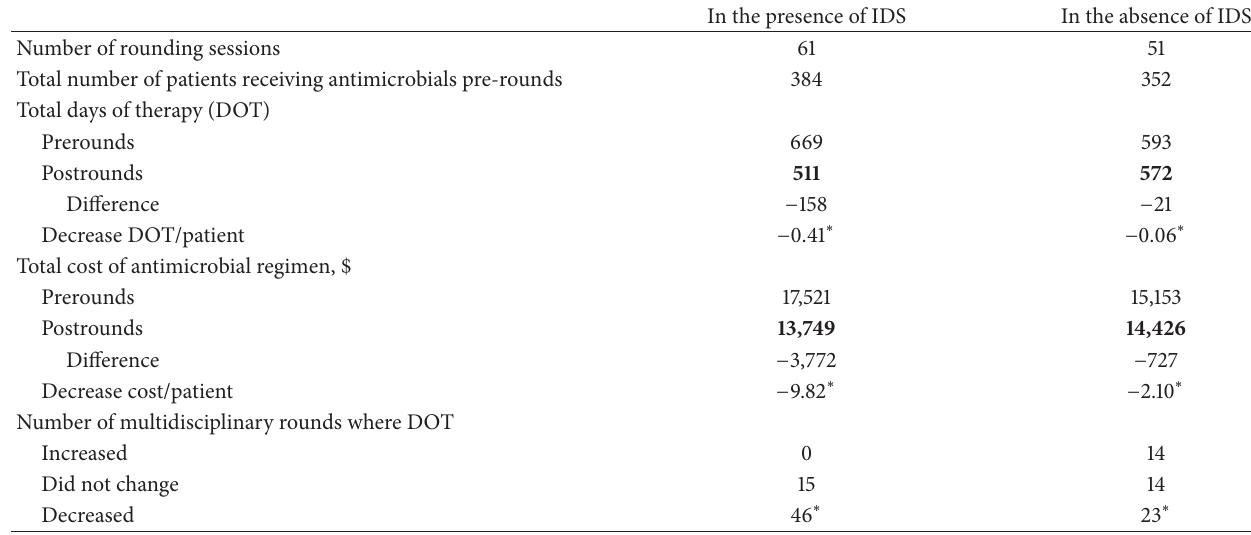
Table 1: Influence of the presence and absence of an infectious diseases specialist (IDS) on antibiotic use decisions by the ICU Multidisciplinary Team at Providence Portland Medical Center. In the presence of IDS In the absence of IDS Number of rounding sessions 61 51 Total number of patients receiving antimicrobials pre-rounds 384 352 Total days of therapy (DOT) Prerounds 669 593 511 572 − 158 − 21 − 0.41 ∗ − 0.06 ∗ 17,521 15,153 13,749